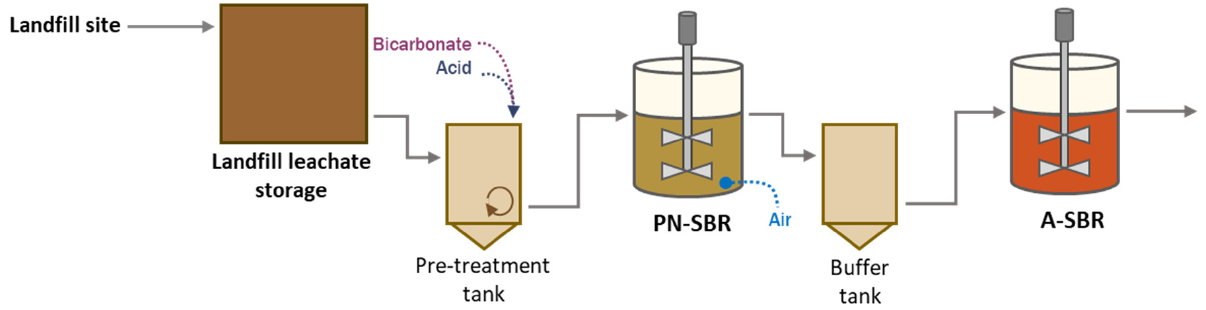
Figure 1. Descriptive scheme for the PANAMMOX ®